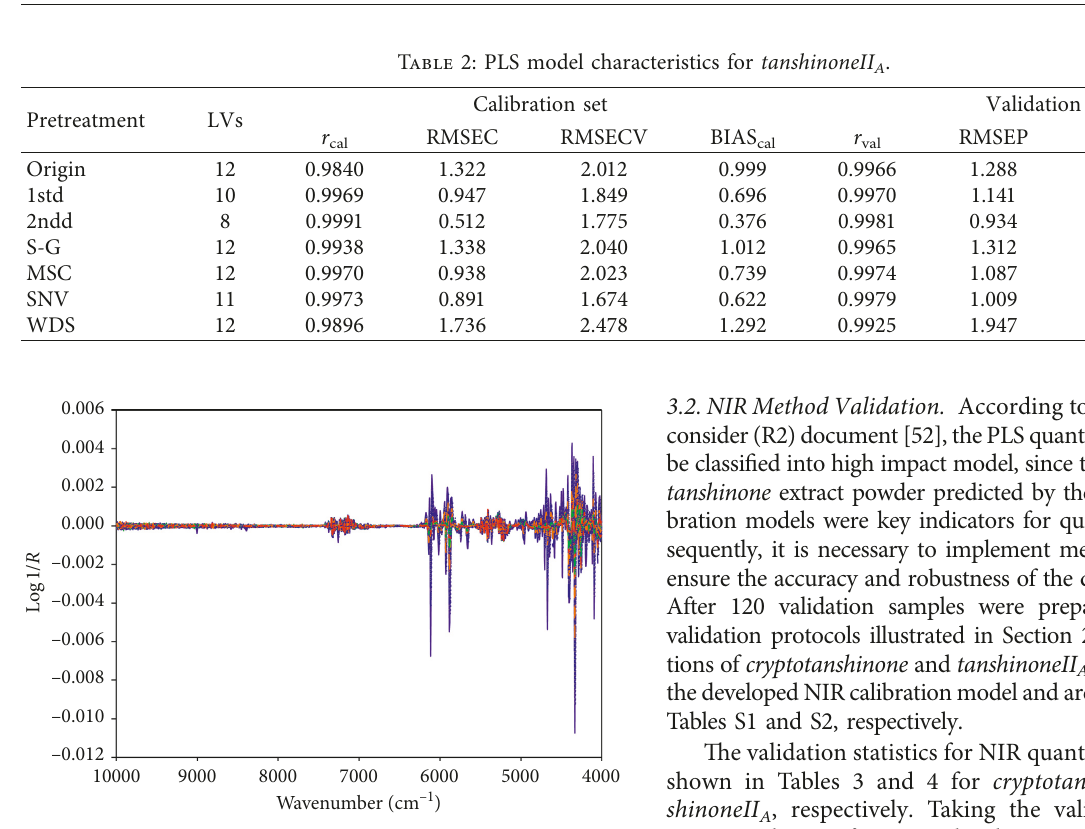
Figure 2: NIR spectra with the 2ndd preprocessing method.